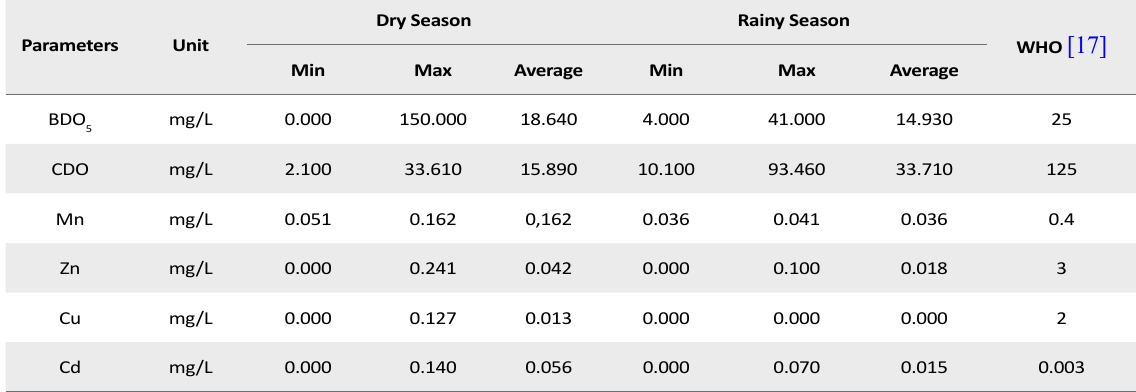
Table 5. Elementary statistics of the physico-chemical parameters of surface waters